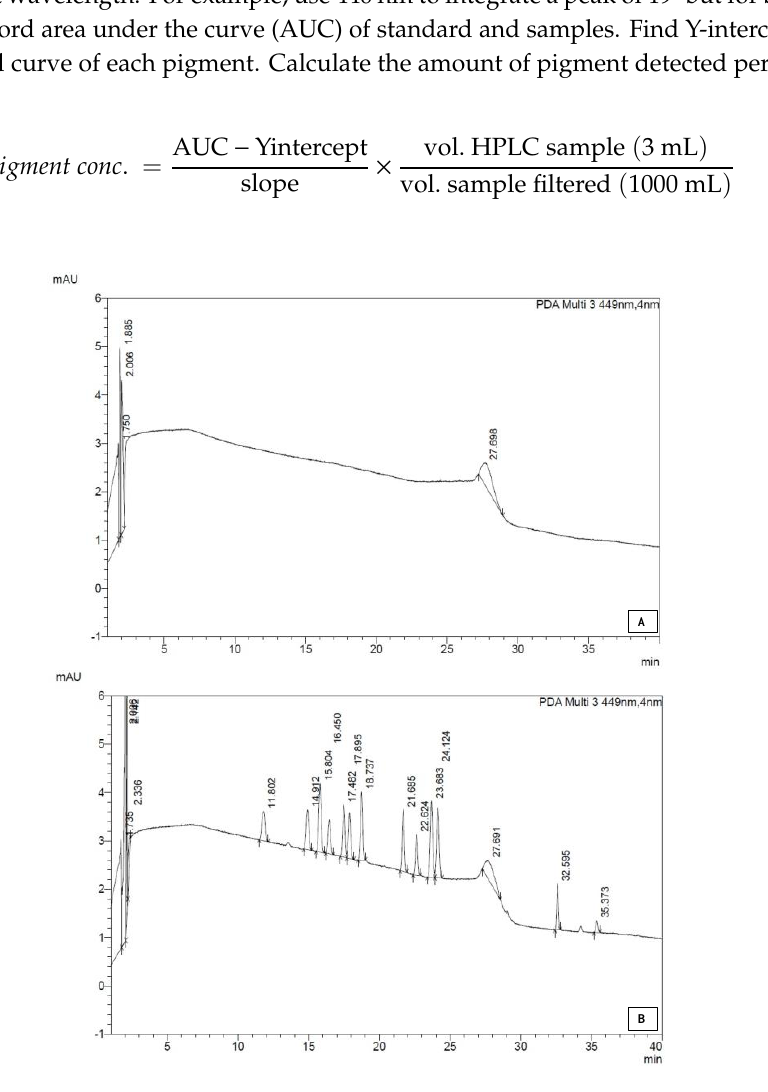
Figure 7. Representative chromatogram of pigments obtained by HPLC-PDA: Peaks detected by the wavelength of 449 nm from ( A ) water, and ( B ) standard mix. This wavelength was used to see all the peaks in a single chromatogram, but each pigment has maximum absorption at a different wavelength. Thus, each pigments quantification is carried out at the wavelength of maximum absorption (Table 2).